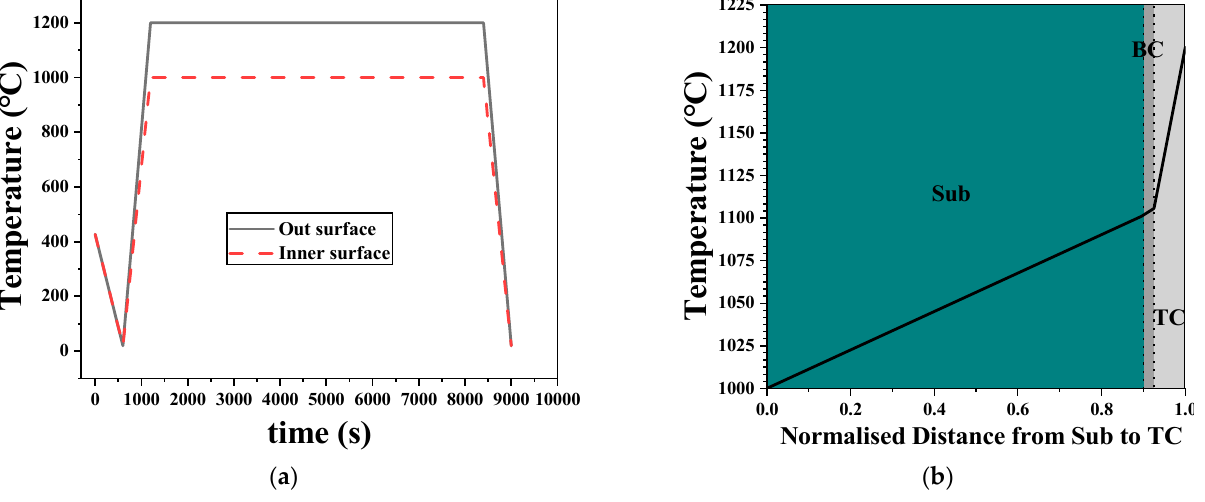
Figure 4. Thermal cycle used in FEM simulation: ( a ) four steps of thermal load: cooling of prestress field, heating, holding, and cooling, ( b ) temperature gradient in TBC at the holding